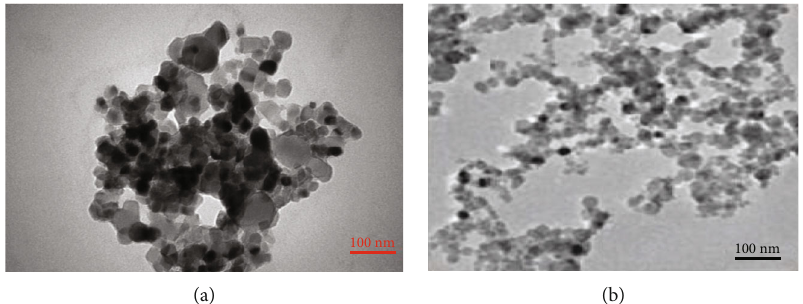
Figure 3: TEM image of TiO